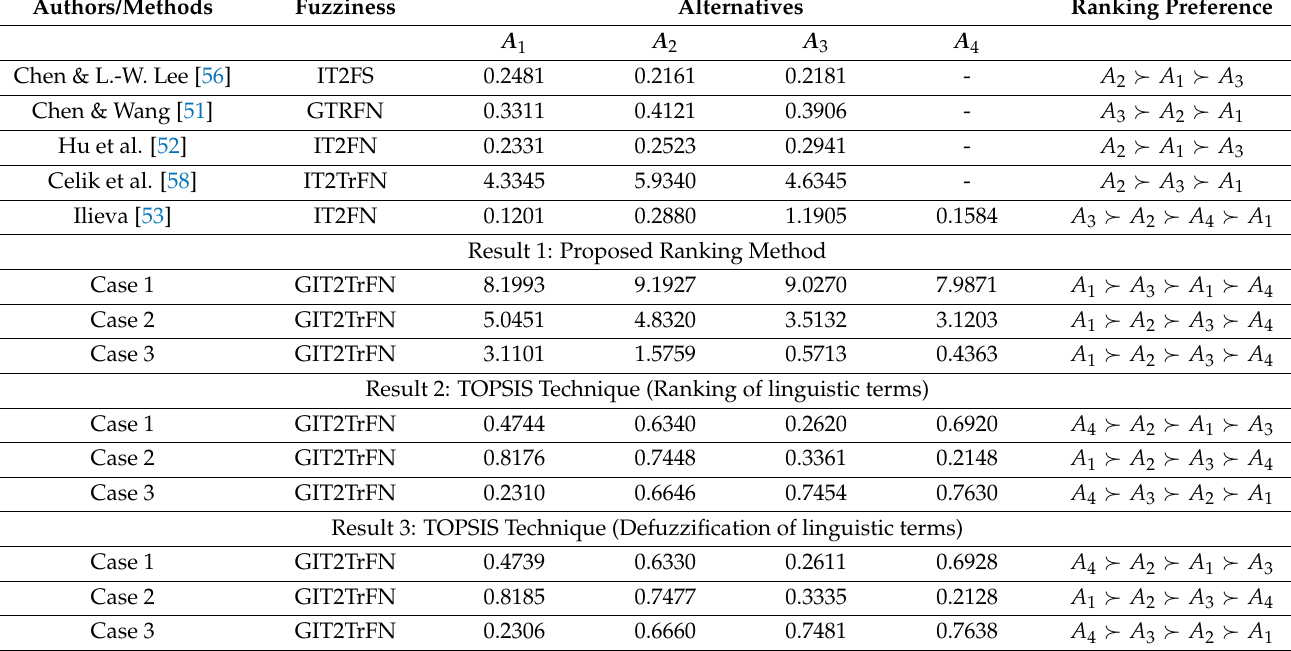
Figure 6. Ranking Performance for presented three cases. Table 9. Comparison of ranking preferences with existing methods.